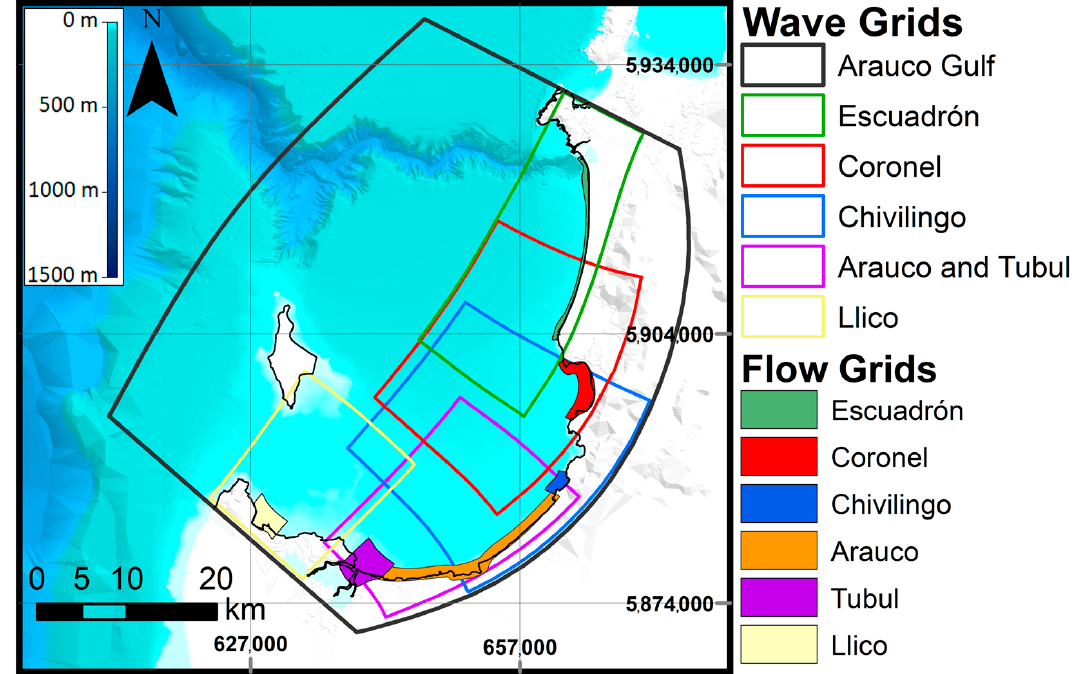
Figure 4. Grid configuration: non shaded contours represent nested grids for each of the beaches in WAVE, while shade contours correspond to detailed grids of the beaches in FLOW.